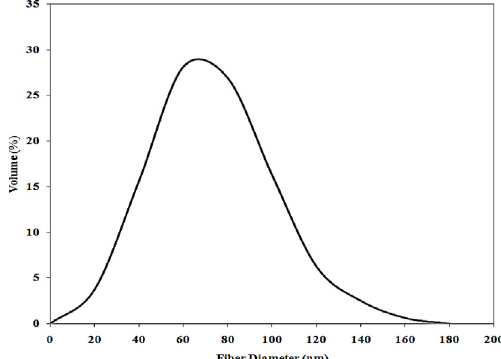
Fig. 3. diameter distribution of aerogel fibers obtained at 50˚C, 3 mL/min, 20 MPa, 7.5% ethanol and DMSO/water of 6 (v/v).